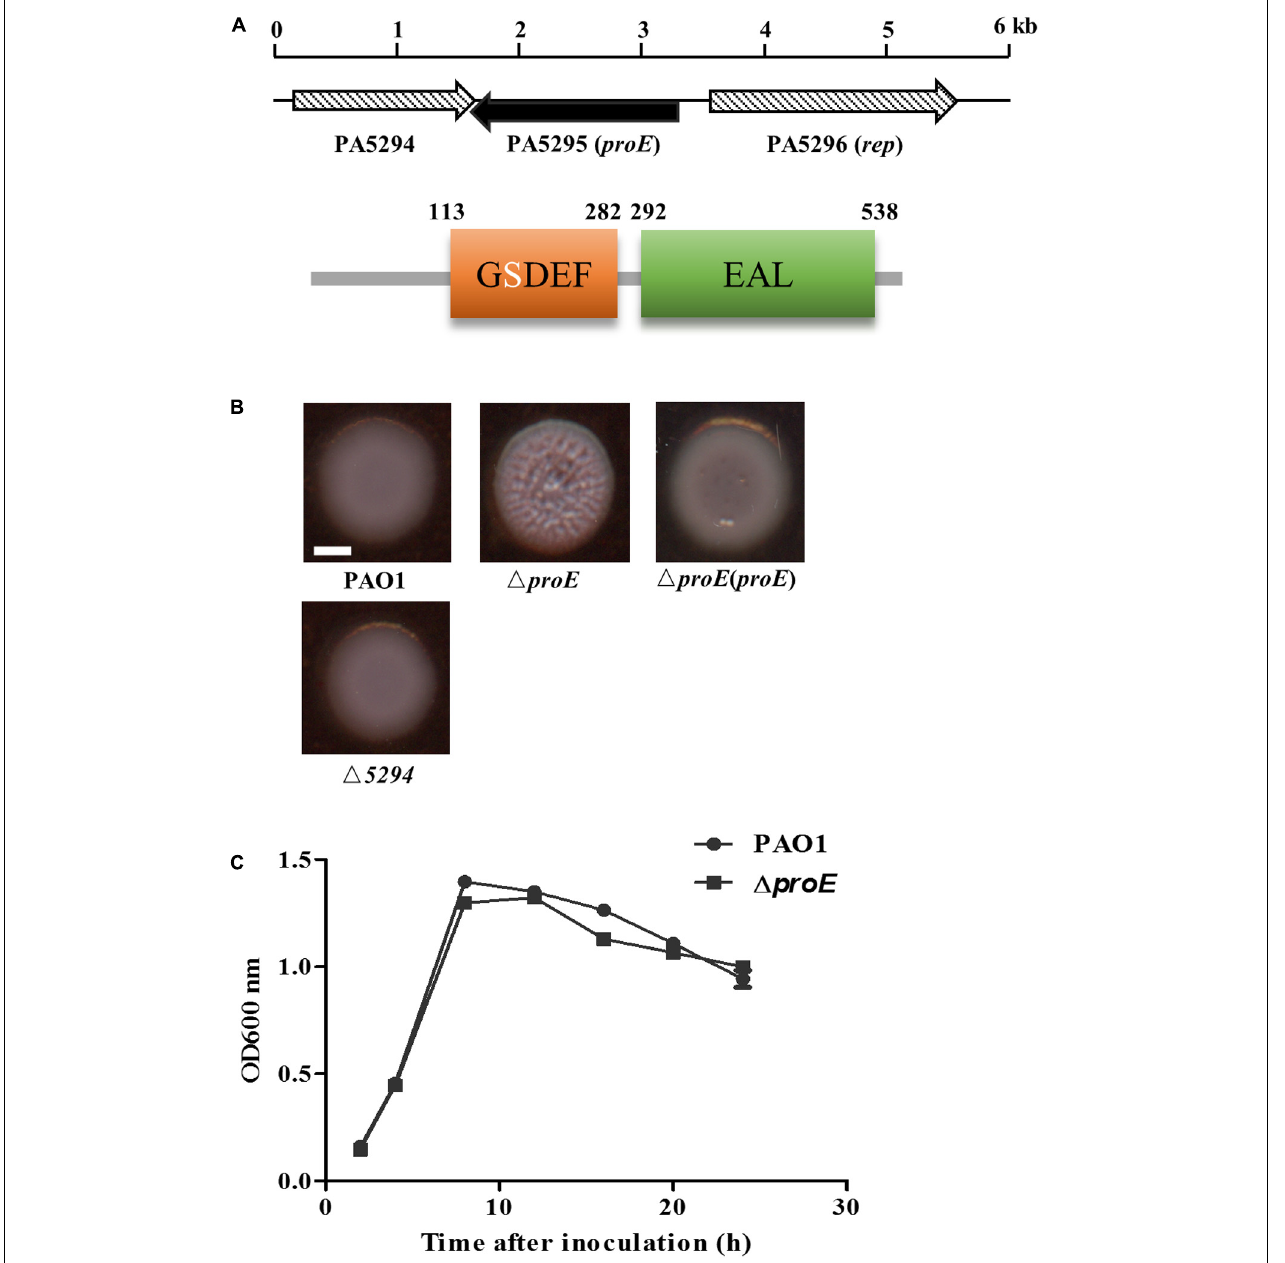
FIGURE 1 | The proE mutant showed a wrinkly colony morphology. (A) Genetic organization and domain structures of ProE, and the active site of the GGDEF domain is degenerate. (B) Mutation of proE affected the colony morphology on Congo-Red plate after growth on 25 ◦ C for 2 days, nor does mutation of PA5294 have the similar phenotype. Scale bar = 2 mm. (C) Growth curves of PAO1 and (cid:49) proE. The data are means of three replicates and error bars indicate standard